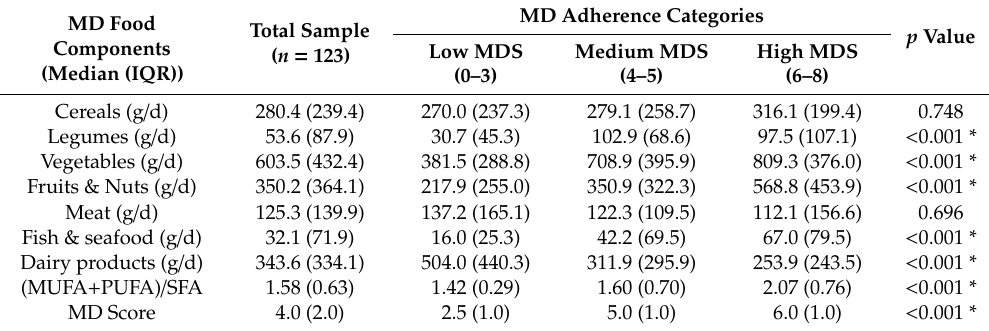
Table 2. Intake of MD individual food components across MD adherence